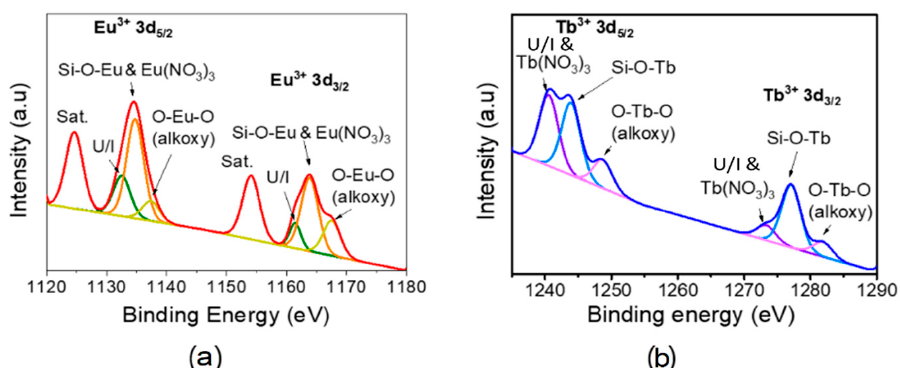
Figure 6. ( a ) High-resolution deconvoluted peaks for Eu 3+ 3d of LPGSQ64–Eu, ( b ) high-resolution deconvoluted peaks for Tb 3+ 3d of LPGSQ64–Tb.